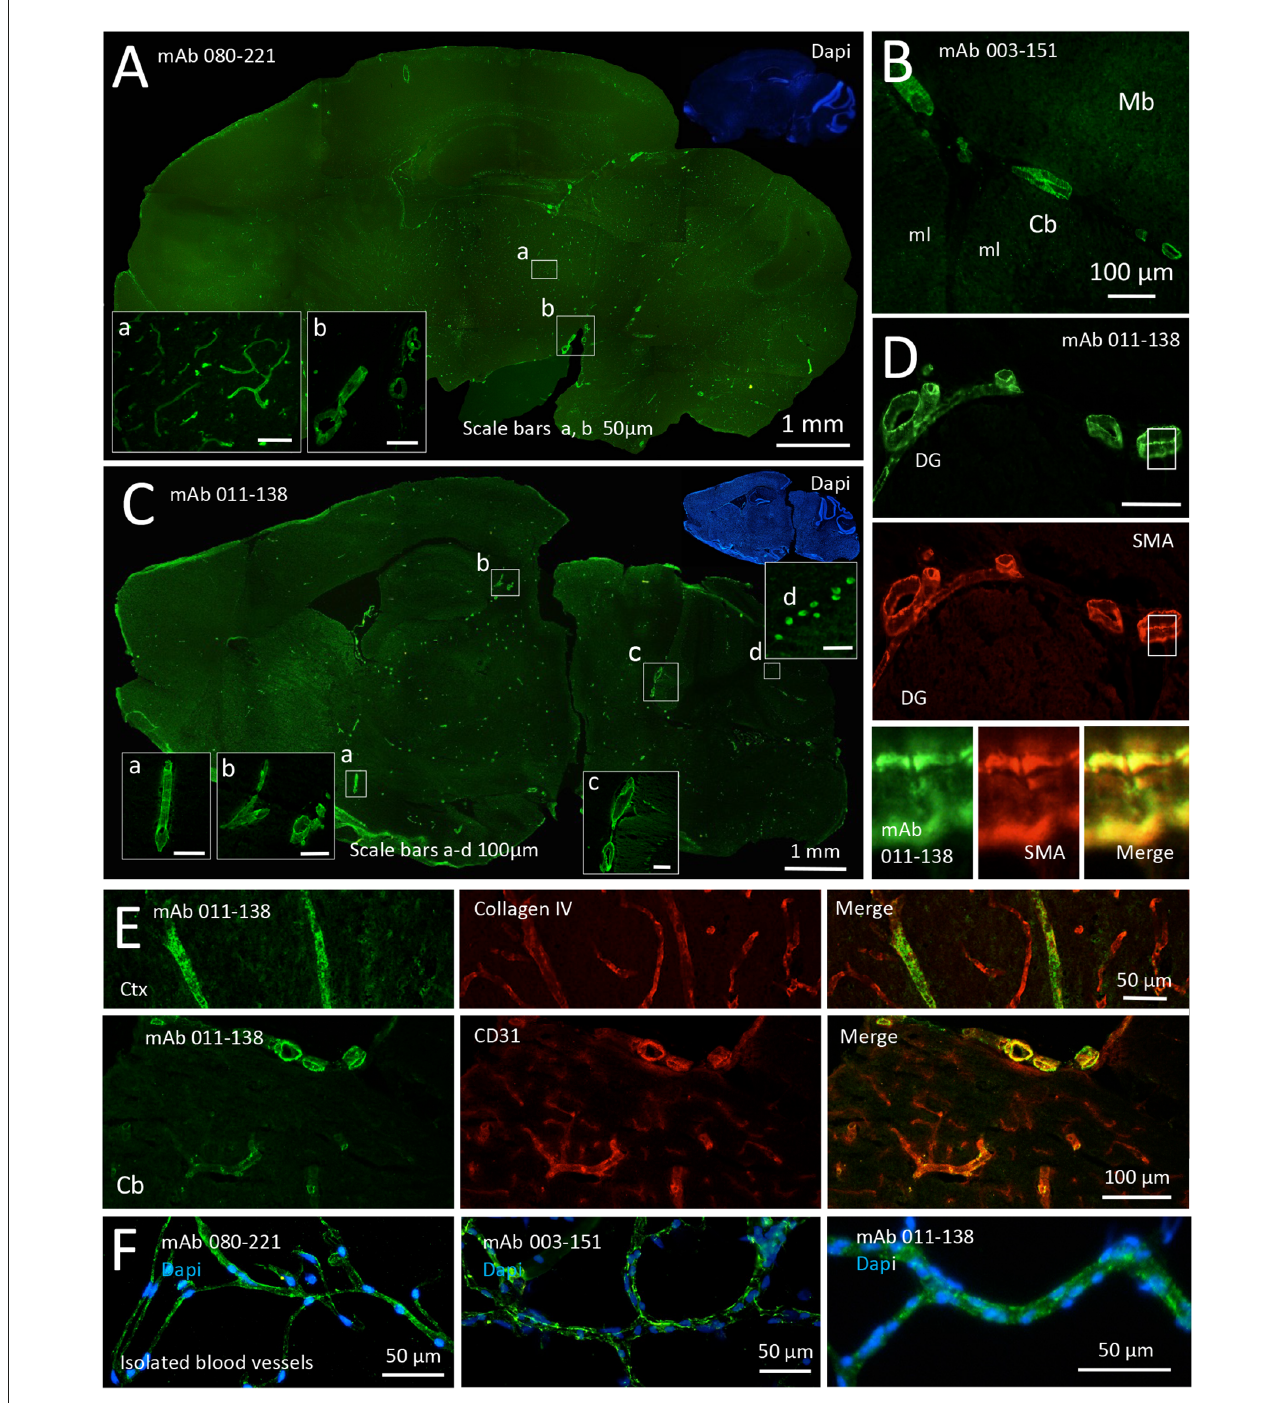
FIGURE2 Recombinant monoclonal antibodies from NMDAR encephalitis patients bind to brain blood vessels and Purkinje cells. Unfixed and unpermeabilized sections from adult mouse brains were incubated with 5 µ g/ml of the respective human monoclonal antibodies (mAbs) obtained from three different patients diagnosed with NMDAR encephalitis. Visualization of tissue binding was performed using a FITC-coupled anti-human IgG secondary antibody. (A) Sagittal brain section incubated with mAb 080-221. Prominent staining of large to small blood vessels including capillaries was obtained in all brain regions (see insets a and b). (B) Sagittal brain section incubated with mAb 003-151. Prominent staining of large to mid-size blood vessels in all brain regions was obtained (a section of cerebellum, Cb , and midbrain, Mb , is shown; ml molecular layer). (C) Sagittal brain section incubated with mAb 011- 138. Prominent staining of large to mid-size blood vessels in all brain regions was obtained (see insets a, b, and c). In addition to blood vessel staining cerebellar Purkinje cells showed marked somatic staining (see inset d). (D) Double staining against human IgG and SMA (smooth muscle actin) in a brain section adjacent to the dentate gyrus ( DG ) of the hippocampus formation. Bound human IgG was mainly detected within the SMA-positive muscle layer of the vessels. (E) Double stainings against Collagen IV (upper panel) and CD31 (lower panel) confirm immunoreactivity of mAb 011-138 to blood vessels . Ctx Cortex (F) Staining of isolated brain blood vessels. Blood vessels were obtained from homogenized mouse brains by combinatory centrifugation and filtering steps. A 30–100 µ m filter size fraction incubation with all three antibodies resulted in clear staining of the vessels within this fraction. Note that the diameter of mounted blood vessels is subject to shrinking artifacts during the staining